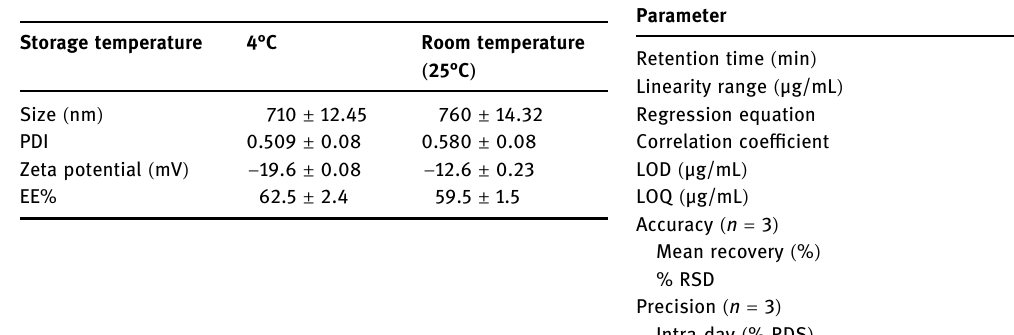
Table 5: Summary of the development and validation of the RP -